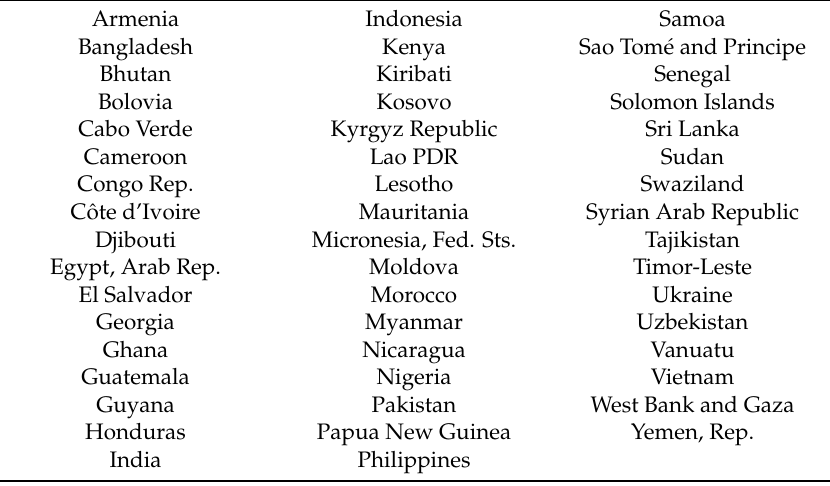
Source: World Bank Group, 2015. Table A2. List of lower-middle economies ($1046 to